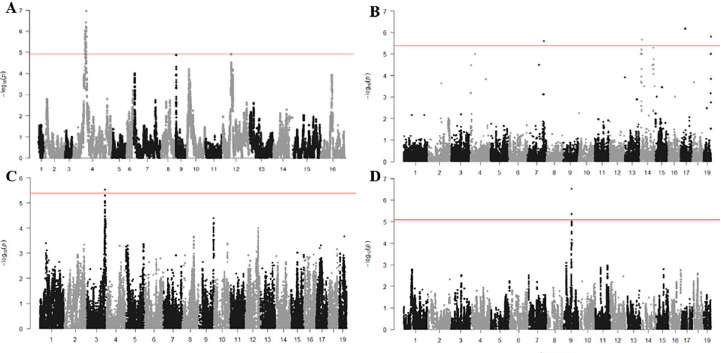
Fig 3. Gx θ results in the yeast, HMDP and LGxSM AIL Cohorts. A) Lithium Chloride Exposure in Yeast B) Cardiac Fibrosis and C) Left Ventricular Weight in the HMDP D) Glucose in the AIL. Significance Threshold in Yeast (A) = 1.2E-5 (FDR 5%) HMDP (B,C) = 4.2E-6[24], AIL (D) = 9.1E-6 (FDR 5%). Summary Statistics may be found in S6–S9